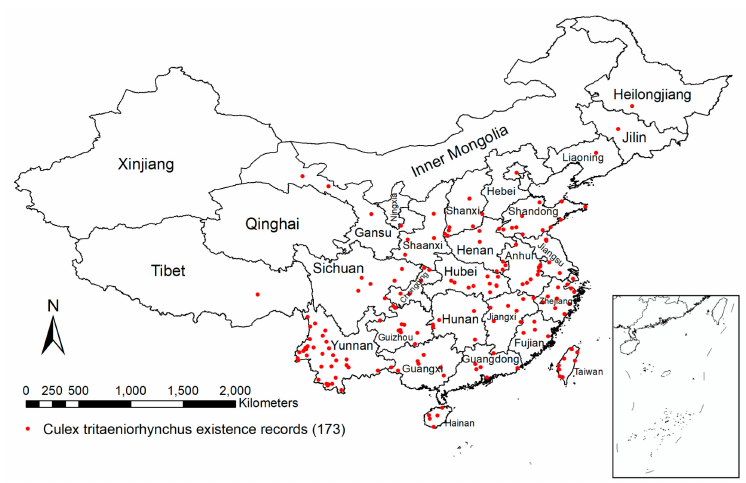
Figure 1. Cx. tritaeniorhynchus existence records. Cx. tritaeniorhynchus existence records in China collected by literature retrieval.